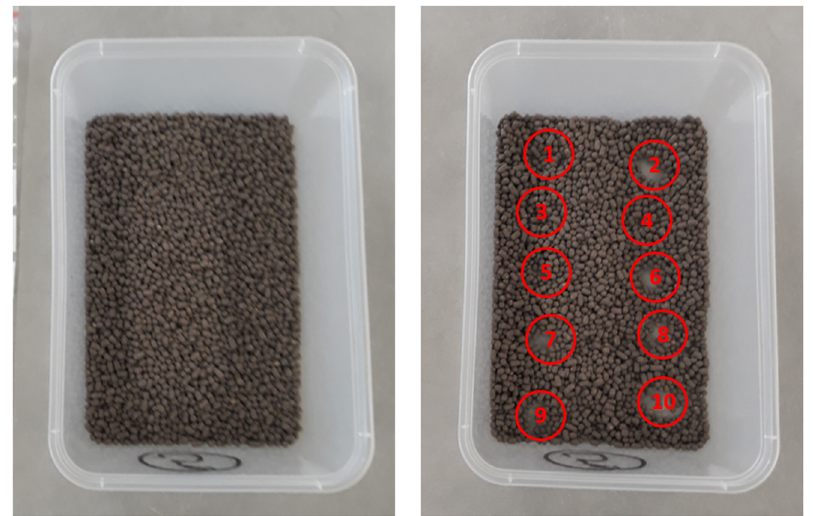
Figure 3. Sampling of the ten spatial replicates of the Regain400 sample. The red circles show the sampled areas.